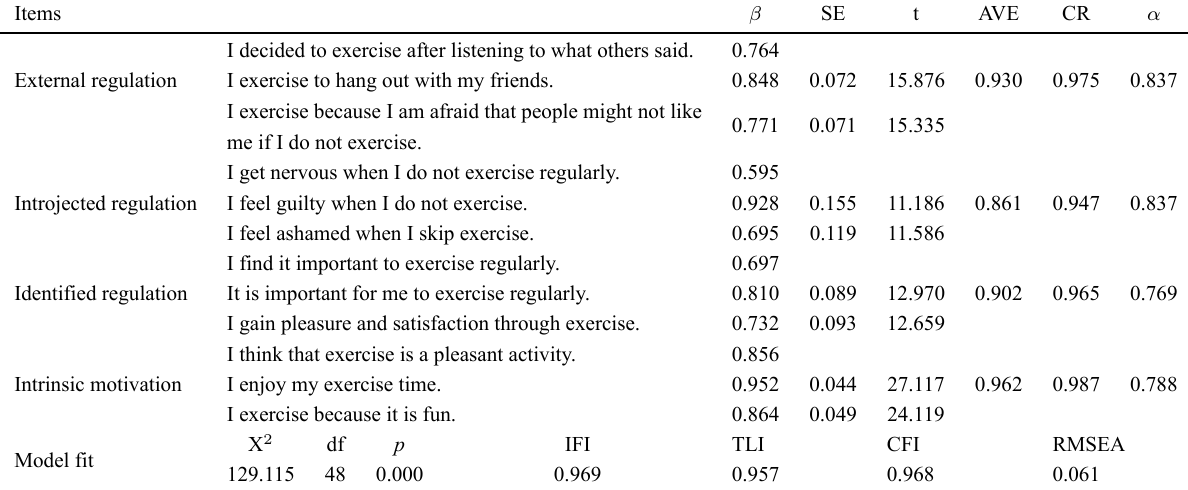
Table 2. Confirmatory factor analysis and reliability analysis of self-determined motivation.